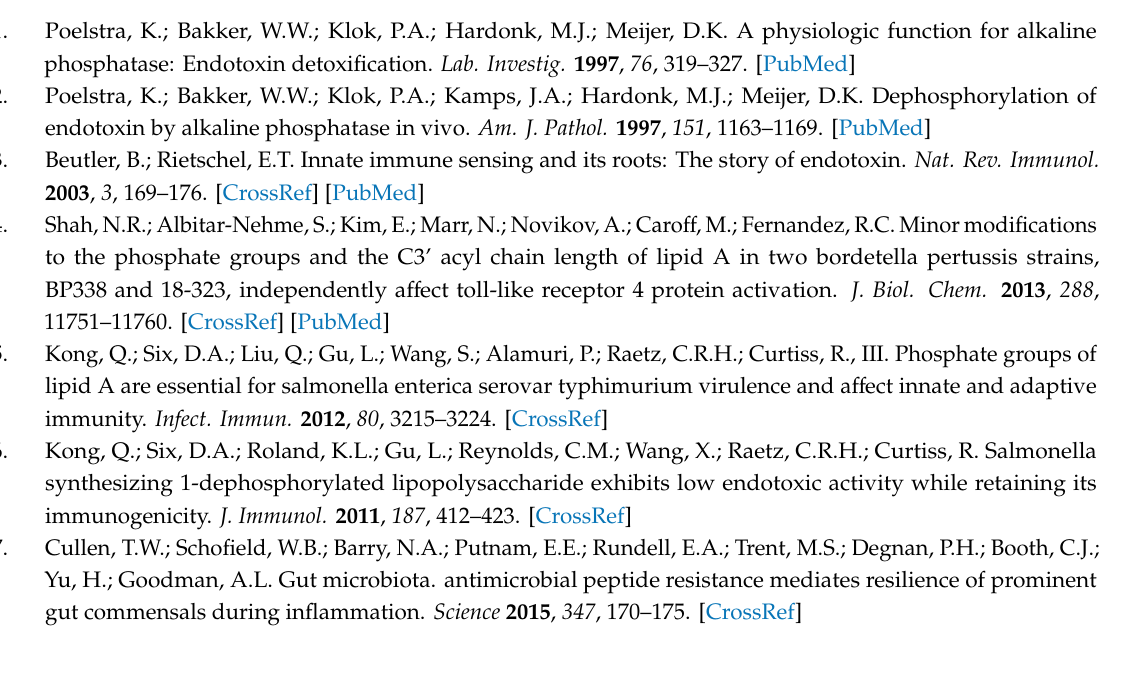
Supplementary Table S1. Patient characteristics of the human livers